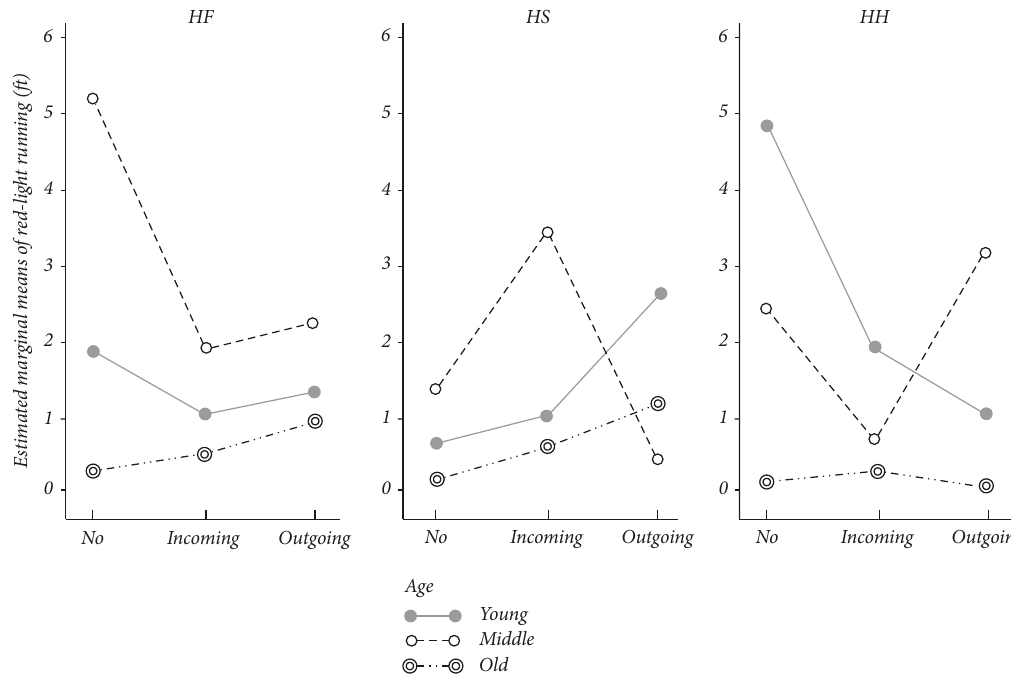
Figure 3: Three-way interaction between cell phone usage, interface, and age influencing red-light running.